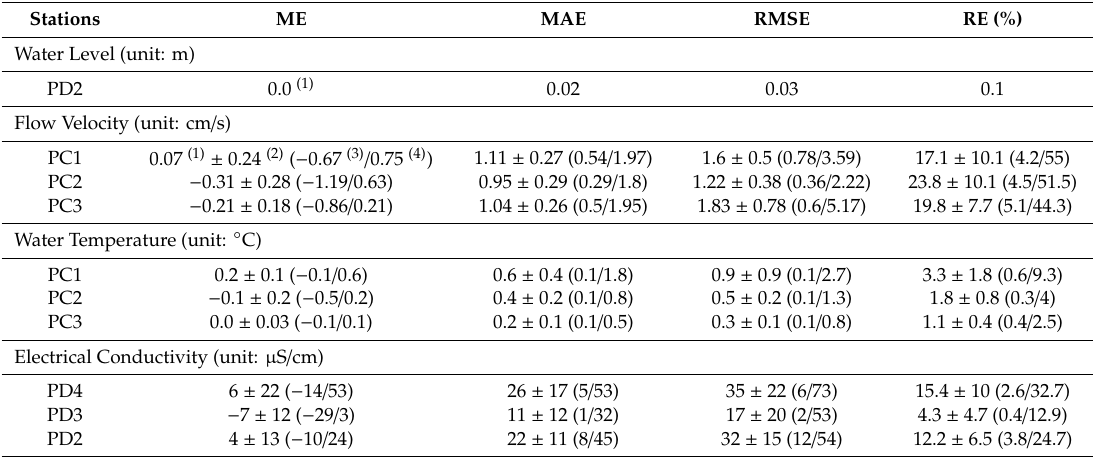
Table 3. Error statistics between observed data and Aquatic Ecosystem Model (AEM3D) simulations on water level, flow velocity, water temperature, and electrical conductivity at each